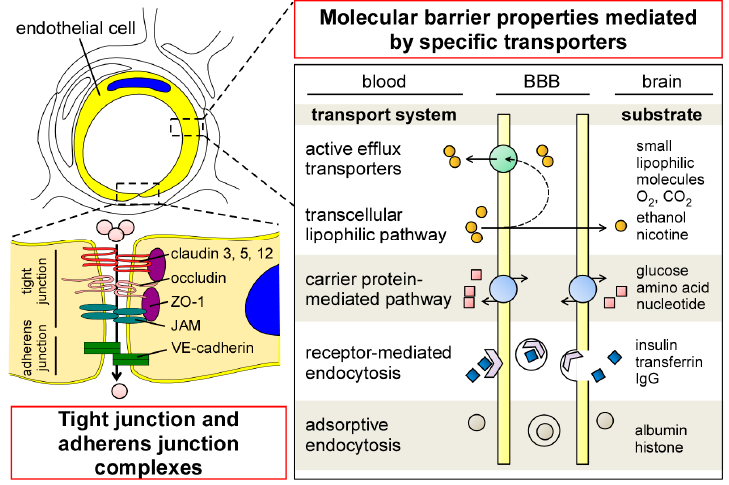
Figure 2. Physical and molecular properties of endothelial cells contributing to BBB integrity and function. Tight junction and adherens junction complexes between endothelial cells restrict paracellular flux across the BBB. In addition, some nutrients and essential molecules are selectively transported from luminal to abluminal membranes by specific influx transport systems. Most of the small lipophilic molecules passively diffused across the lipid bilayer are returned to the blood by ATP-dependent efflux transporters. ZO-1 (zonula occludens-1); JAM (junctional adhesion molecule); VE-cadherin (vascular endothelial-cadherin); lgG (immunoglobulin G).